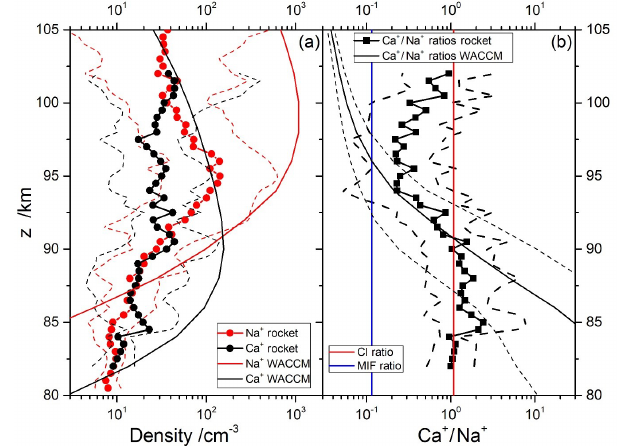
Figure 7. Comparison of observed and modelled Ca + and Na + density profiles: (a) geometric mean profiles of rocket-borne mass spectrometric measurements of Ca + and Na + (circles) with ge- ometric standard deviations (dashed lines), and WACCM model (thick solid lines); (b) geometric mean profiles of the observed (squares) and modelled (thick solid lines) Ca + / Na + ratios, with ge- ometric standard deviations (dashed lines). The Ca / Na abundance ratio in carbonaceous Ivuna (CI) chondrites (Hutchison, 2004) and the ratio of meteor input functions (Carrillo-Sánchez et al., 2016) are indicated with red and blue lines,